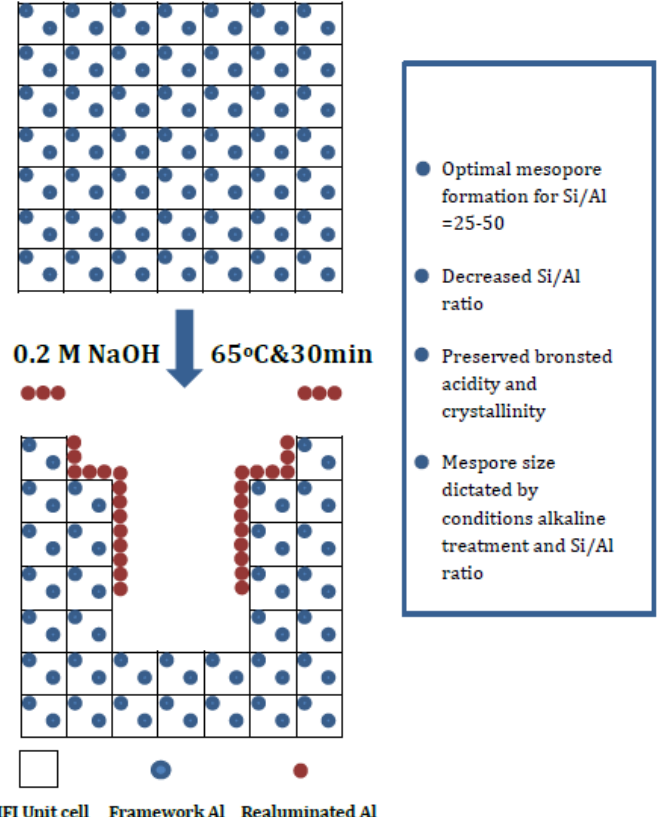
Figure 10. A schematic picture of desilication of MFI zeolite [47]. Reproduced with permission